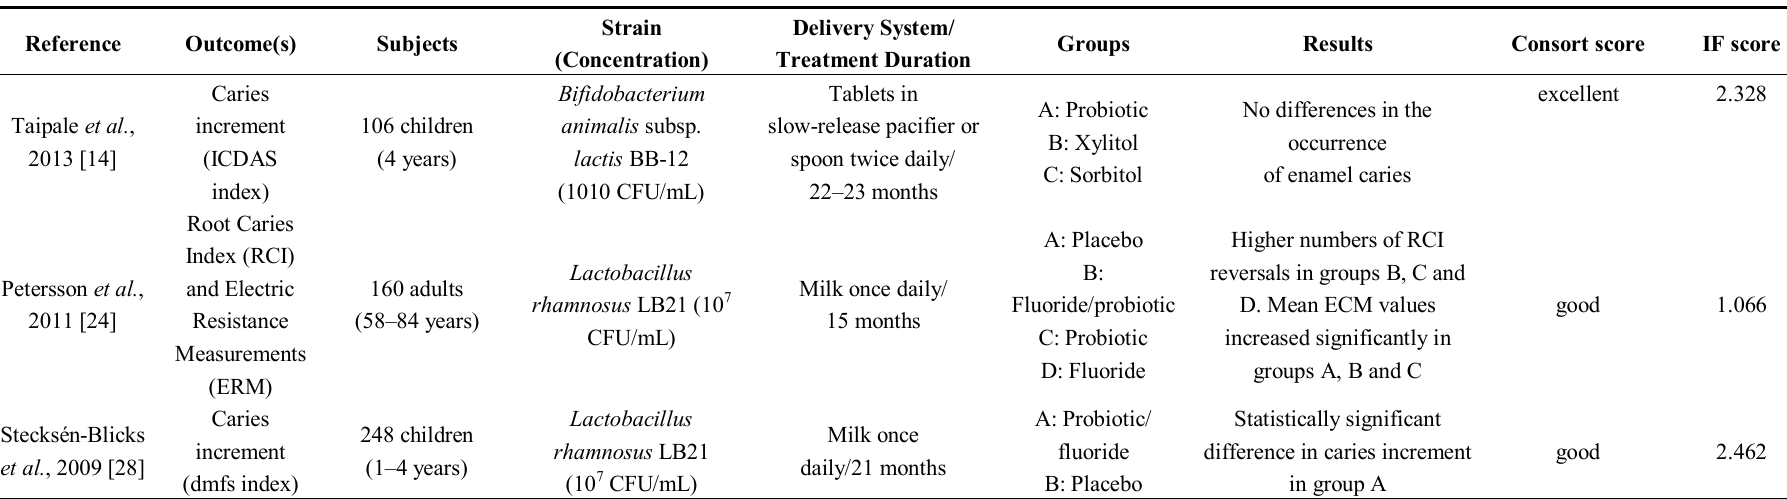
Table 4. Studies with caries lesion development as